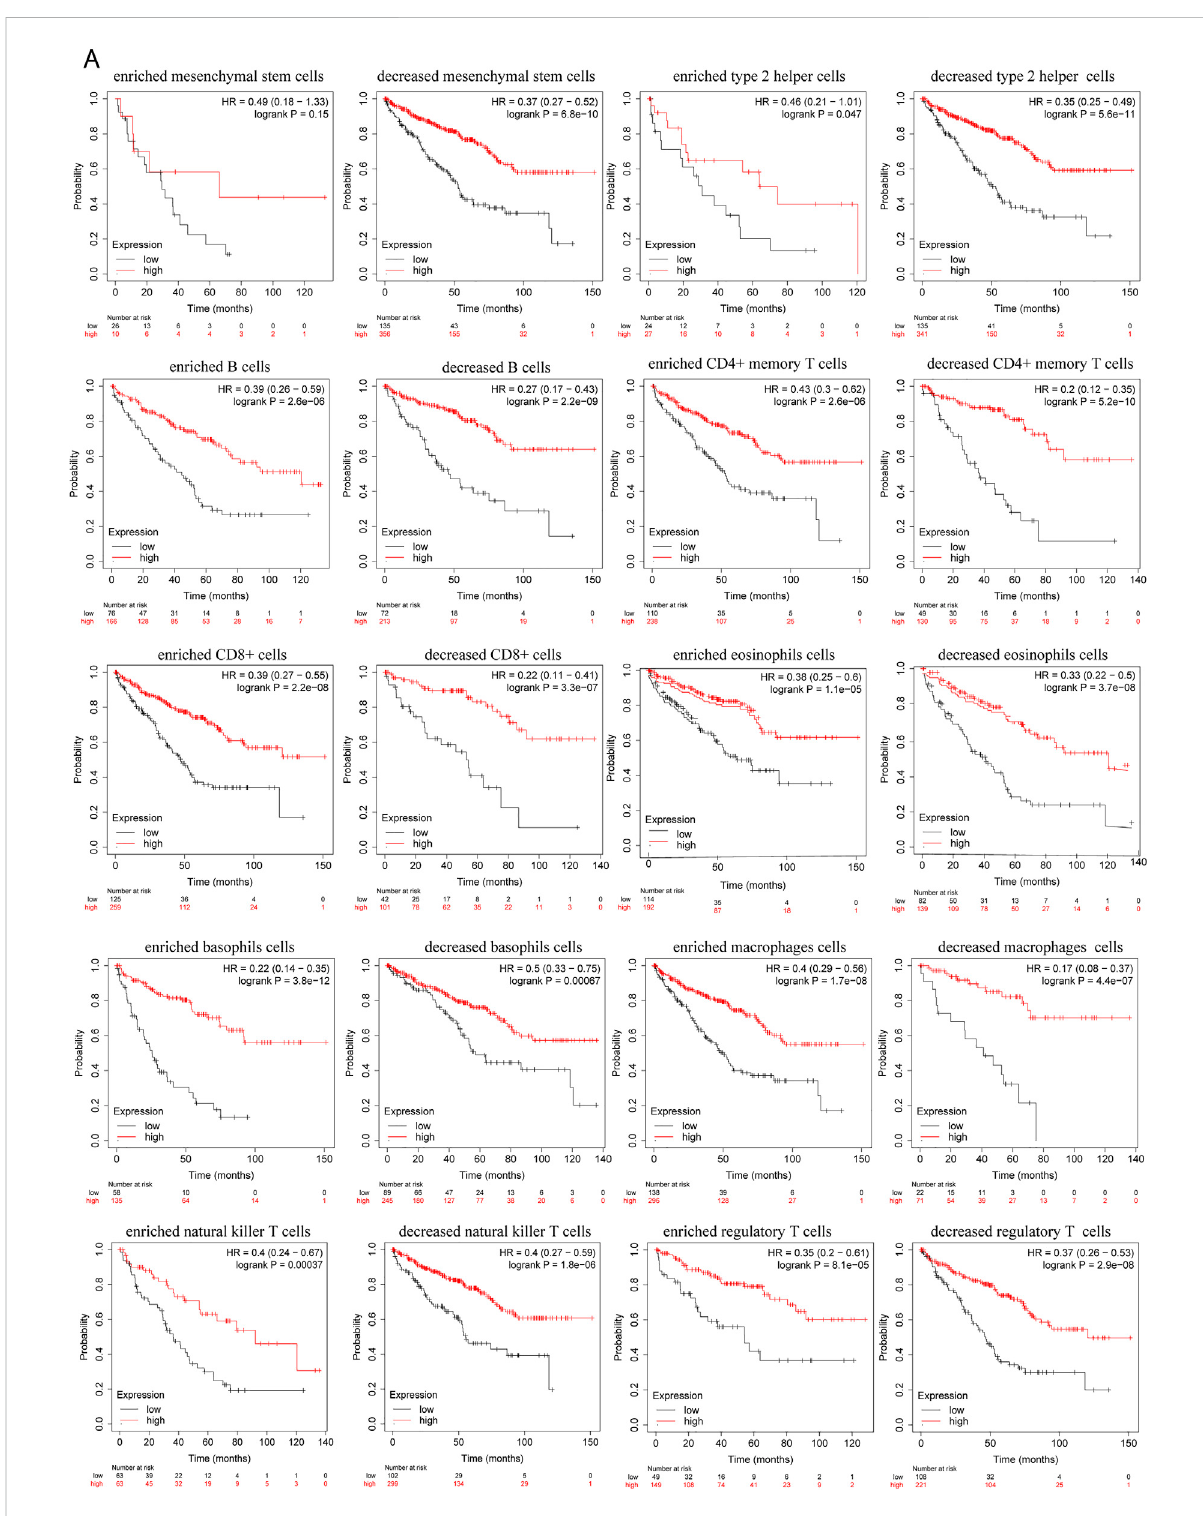
FIGURE 8 Kaplan – Meier survival plots comparing the low and high expression of PRKCE in different types of immune cell subgroups in the Kaplan – Meier plotter. (A) overall survival curves display the prognostic value of PRKCE expression based on different immune cell subgroups in Kaplan-Meier